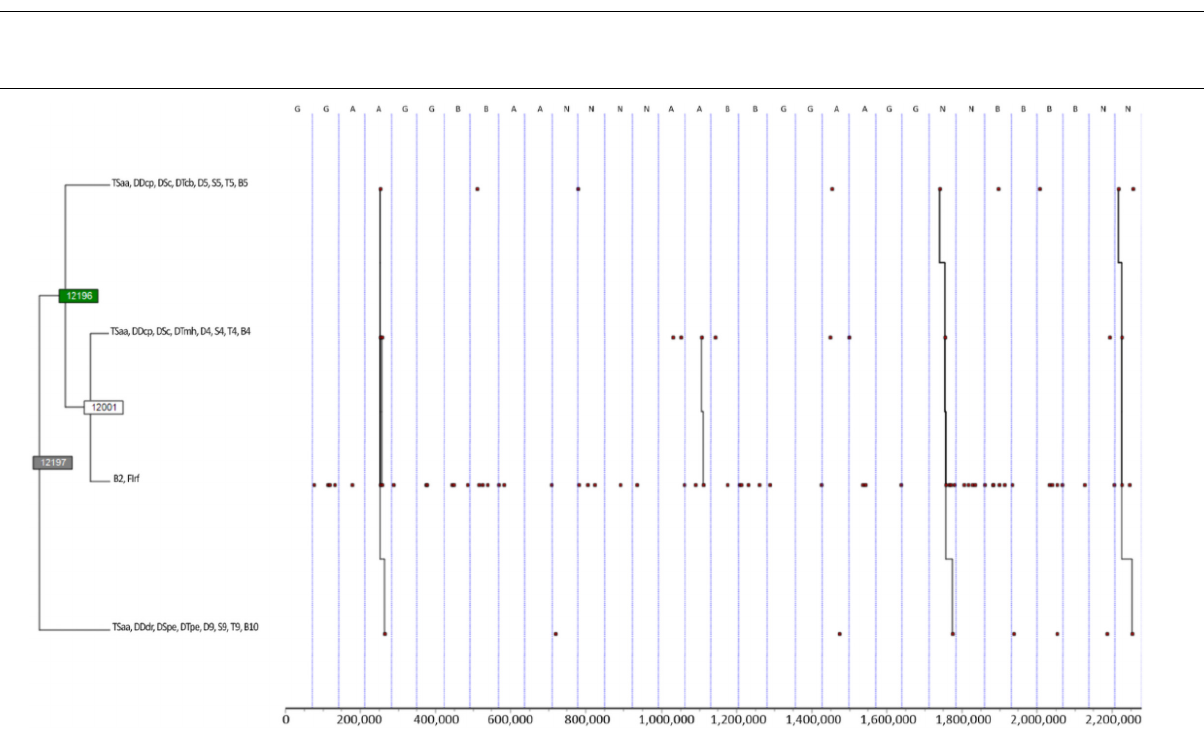
Frontiers in Psychology |